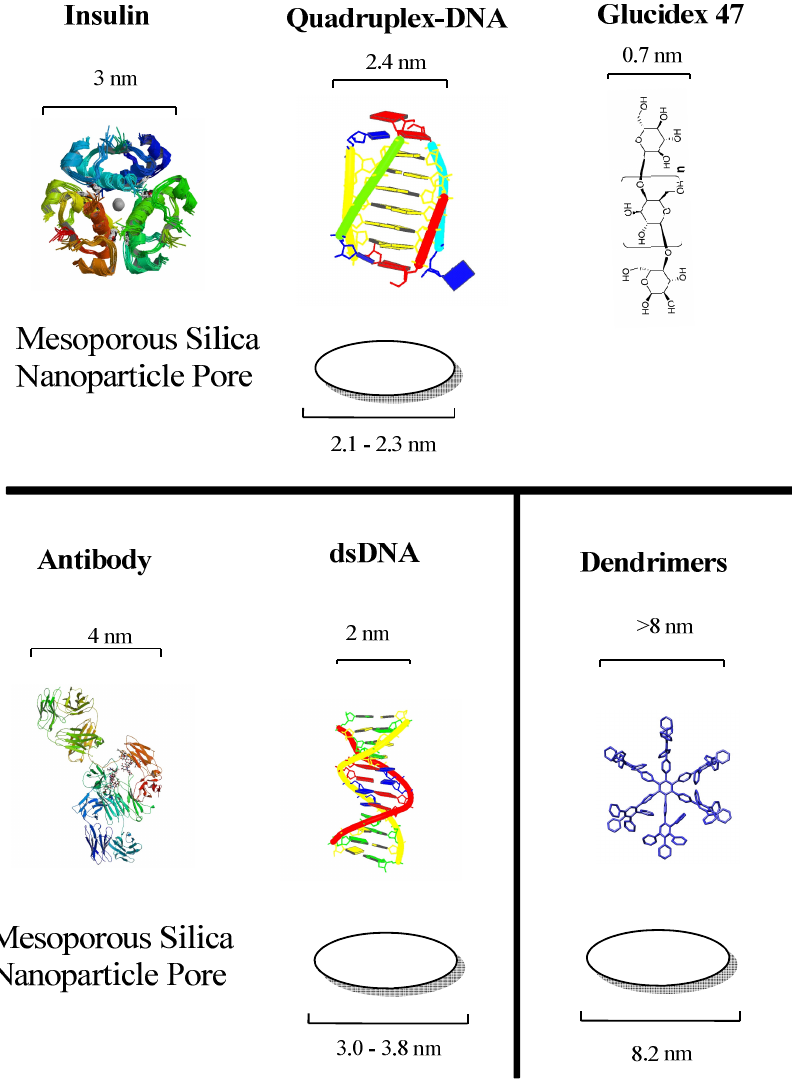
(PDB ID:1AI0), antibody (PDB ID:1IGT), i-motif DNA (PDB ID:1CN0) and double stranded DNA (dsDNA, PDB ID:1BNA). The dimensions for Glucidex 47 is based on the size of glucose molecules (KEGG ID: C00031) and dendrimer size was from Arotiba et al.